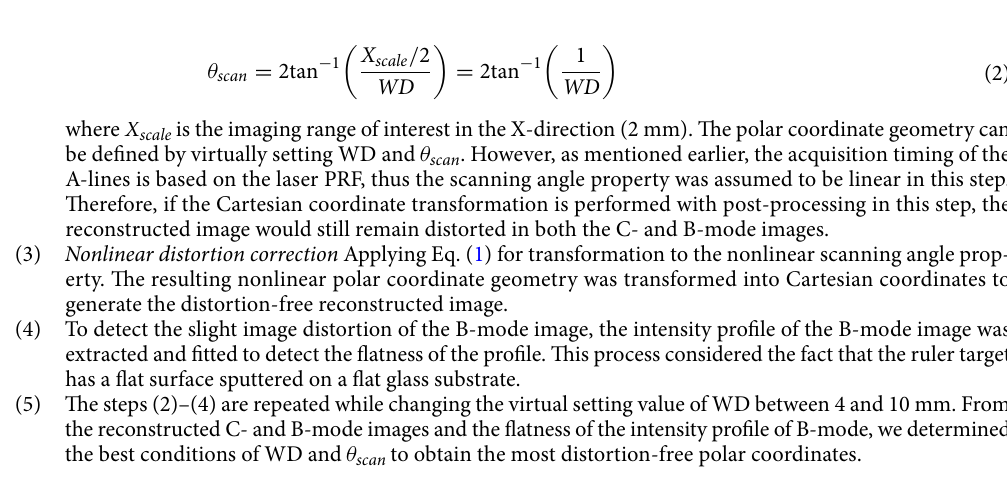
Figure 4. Schematic for carbon fiber preparation. ( a ) Horizontally stretched for axial resolution measurement. ( b ) Vertically tilted for DOF